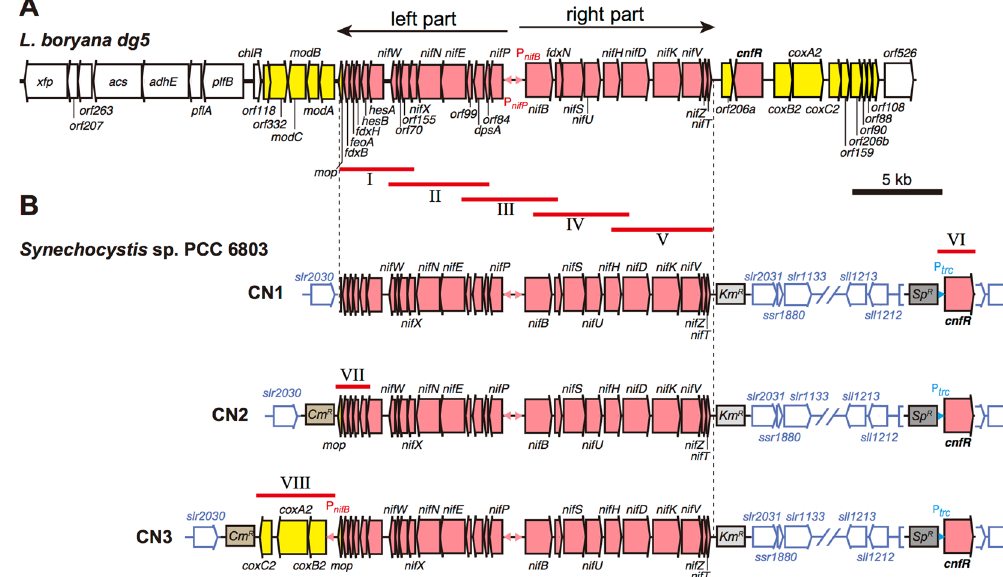
Figure 1. ( A ) The 50-kb nif gene cluster in L. boryana dg5 . Genes that were transferred to the genome of Synechocystis 6803 to isolate CN1 are shown in pink. Genes in this central region (shown in two arrows of right and left parts) are divergently transcribed from the nifB (P nifB ) and nifP (P nifP ) promoters (shown by small pink triangles). Expression of all these genes except cnfR is dependent on CnfR 29 . Genes denoted in yellow show the highest transcript levels under nitrogen fixing conditions and their transcripts are still detected in the absence of cnfR ( ∆ cnfR ), albeit lower than wild type 29 . Subfragments I–V introduced sequentially into the genome neutral site III are shown by red lines. ( B ) Gene arrangements of the transferred nif gene cluster in Synechocystis 6803 transformants CN1, CN2, and CN3. Subfragments VI, VII, and VIII (red lines) were used for isolation of CN1, CN2, and CN3,